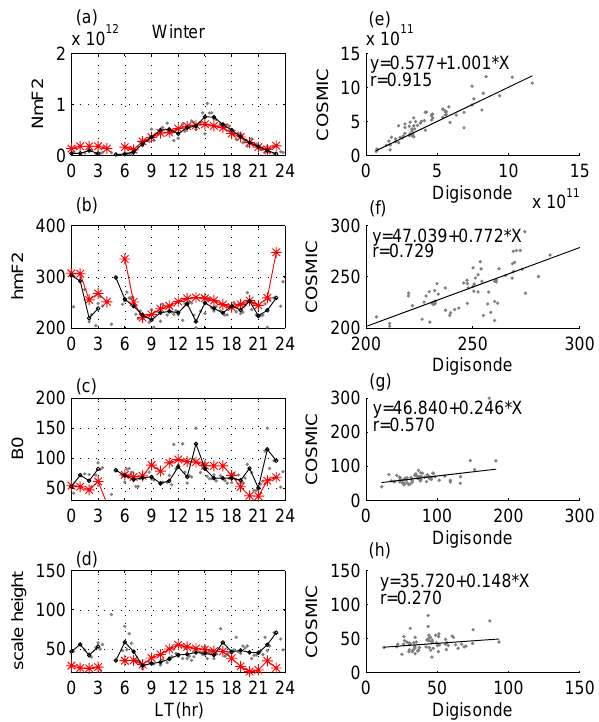
Fig. 5. (a) – (d) Comparison of the diurnal variations obtained from ground-based observations (red asterisk) and RO measurements (circled line) and (e) – (h) scatter plots for the Nm F2, hm F2, B 0, and H T parameter during